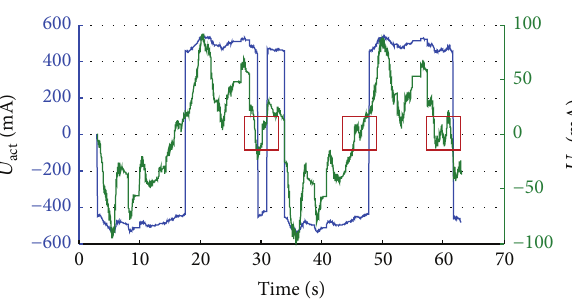
Figure 9: Effect of the double-direct dead-zone